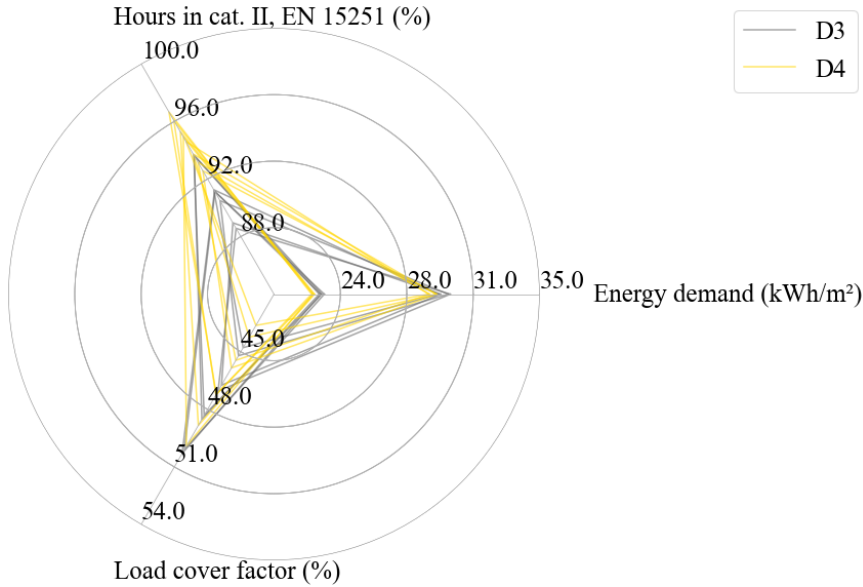
Figure 5. Comparison of the results for all KPIs in D3 and D4 across the eight scenarios.